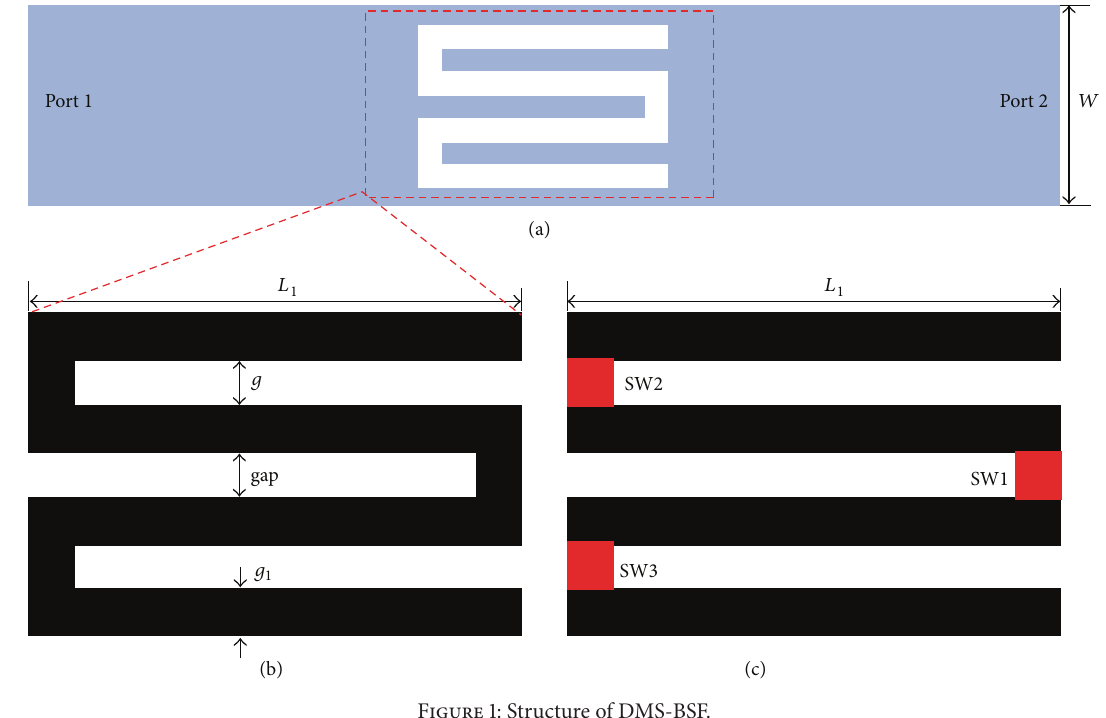
Figure 1: Structure of